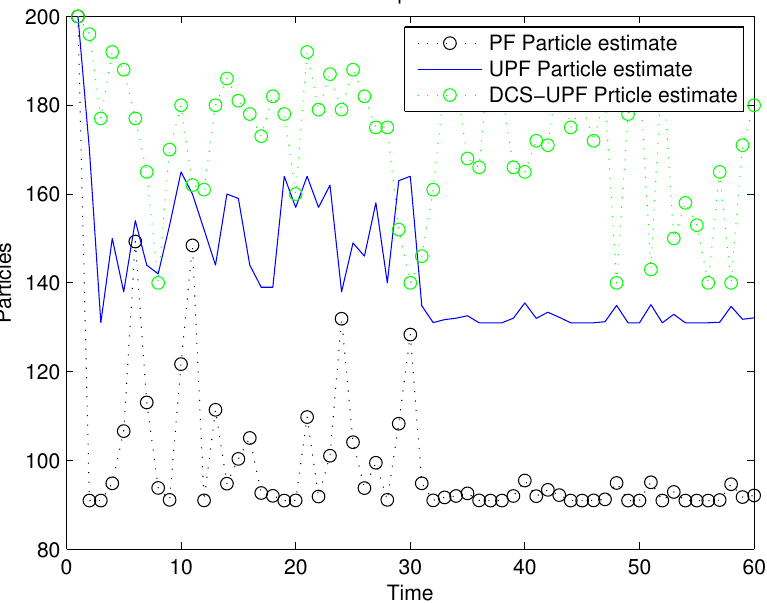
Figure 12. The effective particles numbers of three filters in